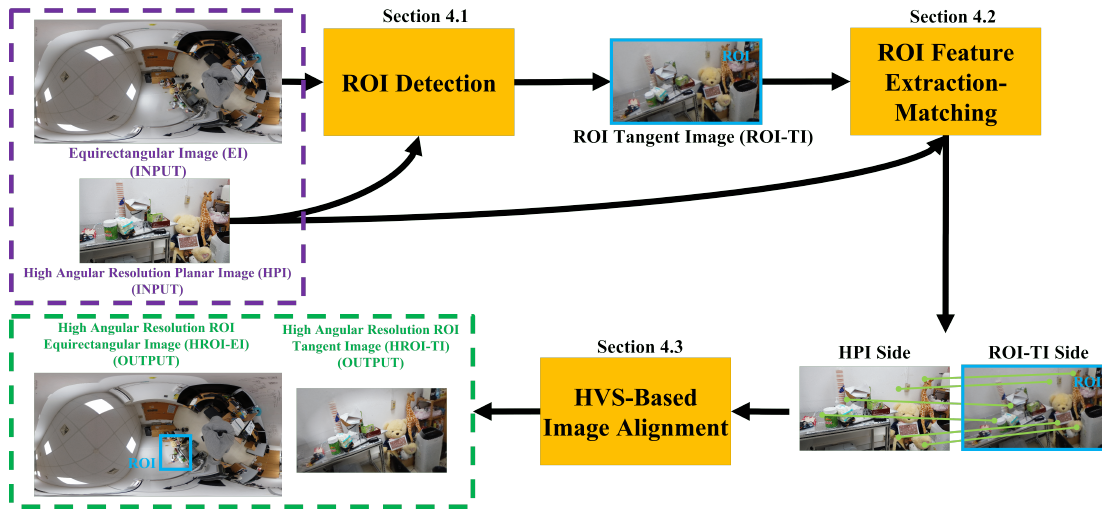
Figure 4. Planar-equirectangular image stitching pipeline. The pipeline consists of three steps: (1) ROI detection, (2) ROI feature extraction-matching, and (3) HVS-based image alignment. The pipeline process high angular resolution planar image (HPI)-equirectangular image (EI) pair and result in high angular resolution ROI tangent image (HROI-TI) and high angular resolution ROI EI (HROI-EI). Zoom-in the figure to see the resolution difference between the ROI tangent image (ROI-TI) and the HROI-TI, and between the EI and the